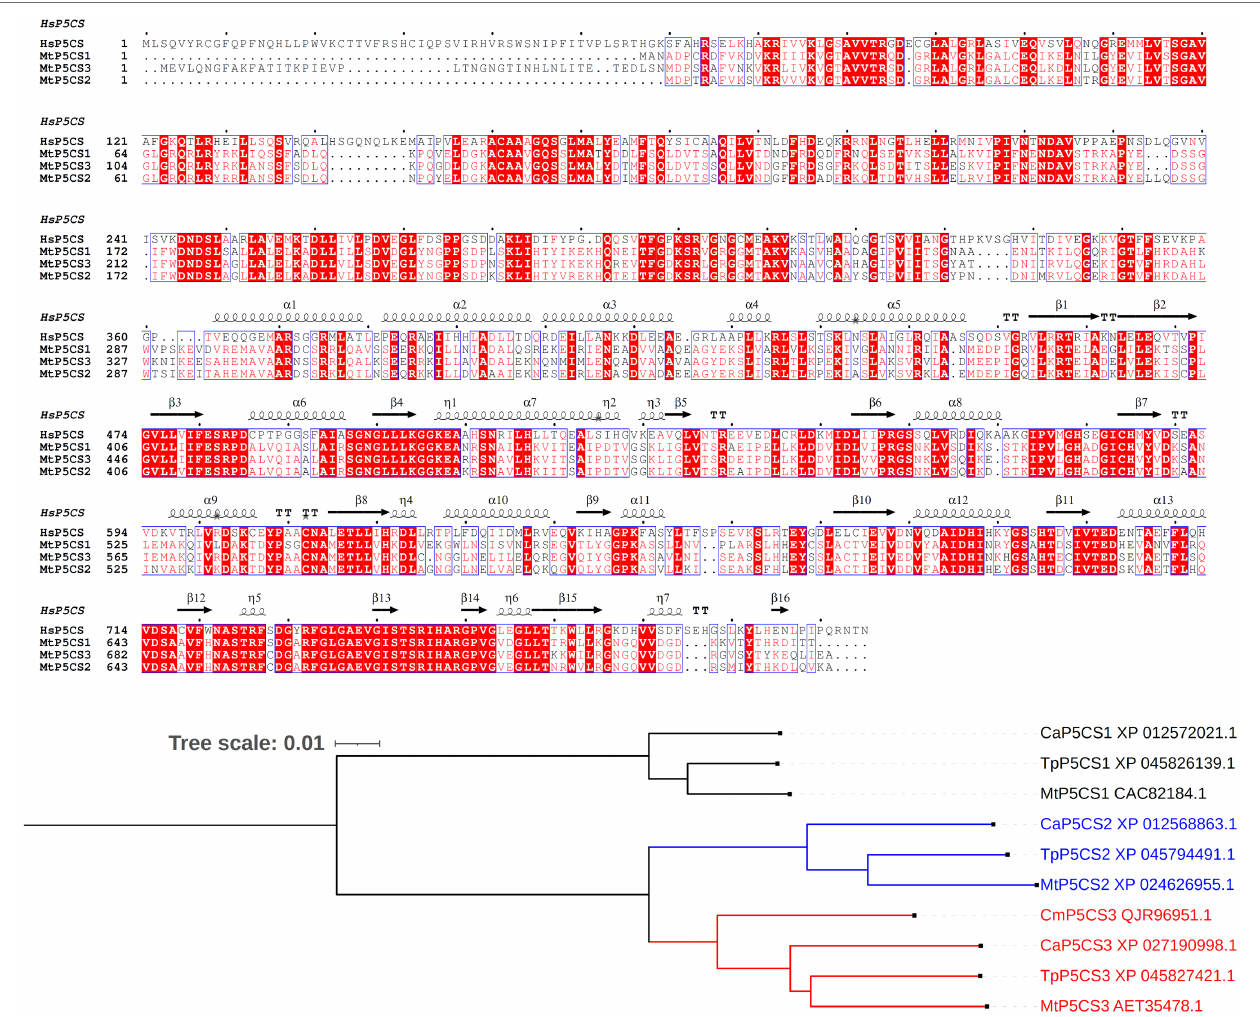
FIGURE 2 | Legume-specific isozymes of δ 1 -pyrroline-5-carboxylate synthetase. Upper panel : Multiple sequence alignment of Medicago truncatula P5CS isoforms. The three proteins described in barrel clover (Kim and Nam, 2013) and the human enzyme (X94453.1) have been aligned using Clustal Omega (Madeira et al., 2019) and Espript 3.0 (Robert and Gouet, 2014). Sequence identities are emphasized in red and similarities are highlighted as red letters. The corresponding secondary structure of Homo sapiens P5CS, the only enzyme form whose architecture has been partially resolved (PDB id 2H5G), is shown on the top. Helices appear as scribble, β -strands as arrows. Lower panel : Occurrence of a third P5CS isozyme in other legumes. The sequence of the 43-aa extra amino-terminal segment of Mt P5CS3 was used as a query for a sequence similarity search using BLAST (https://blast.ncbi.nlm.nih.gov/Blast.cgi). No significant similarity was found other than in legumes. A few incomplete or redundant sequences were discarded, resulting in three sequences from Trifolium pratense , Cicer arietinum , and Caragana microphylla . These sequences were aligned with the other two canonical P5CS isoforms, and used for maximum likelihood tree reconstruction using Clustal Omega with default parameters. Tree visualization was obtained using iTol, version 6.5.2 (Letunic and Bork, 2021). For C. microphylla , P5CS1 and P5CS2 sequences were not